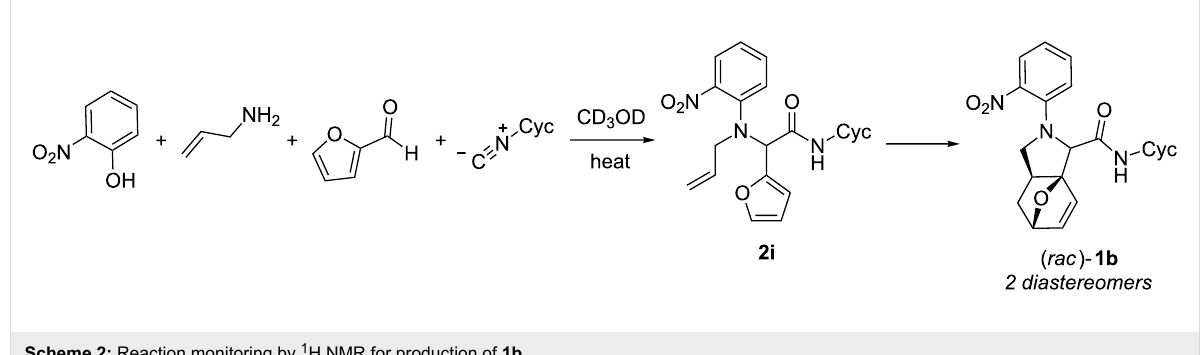
Scheme 2: Reaction monitoring by 1 H NMR for production of 1b .